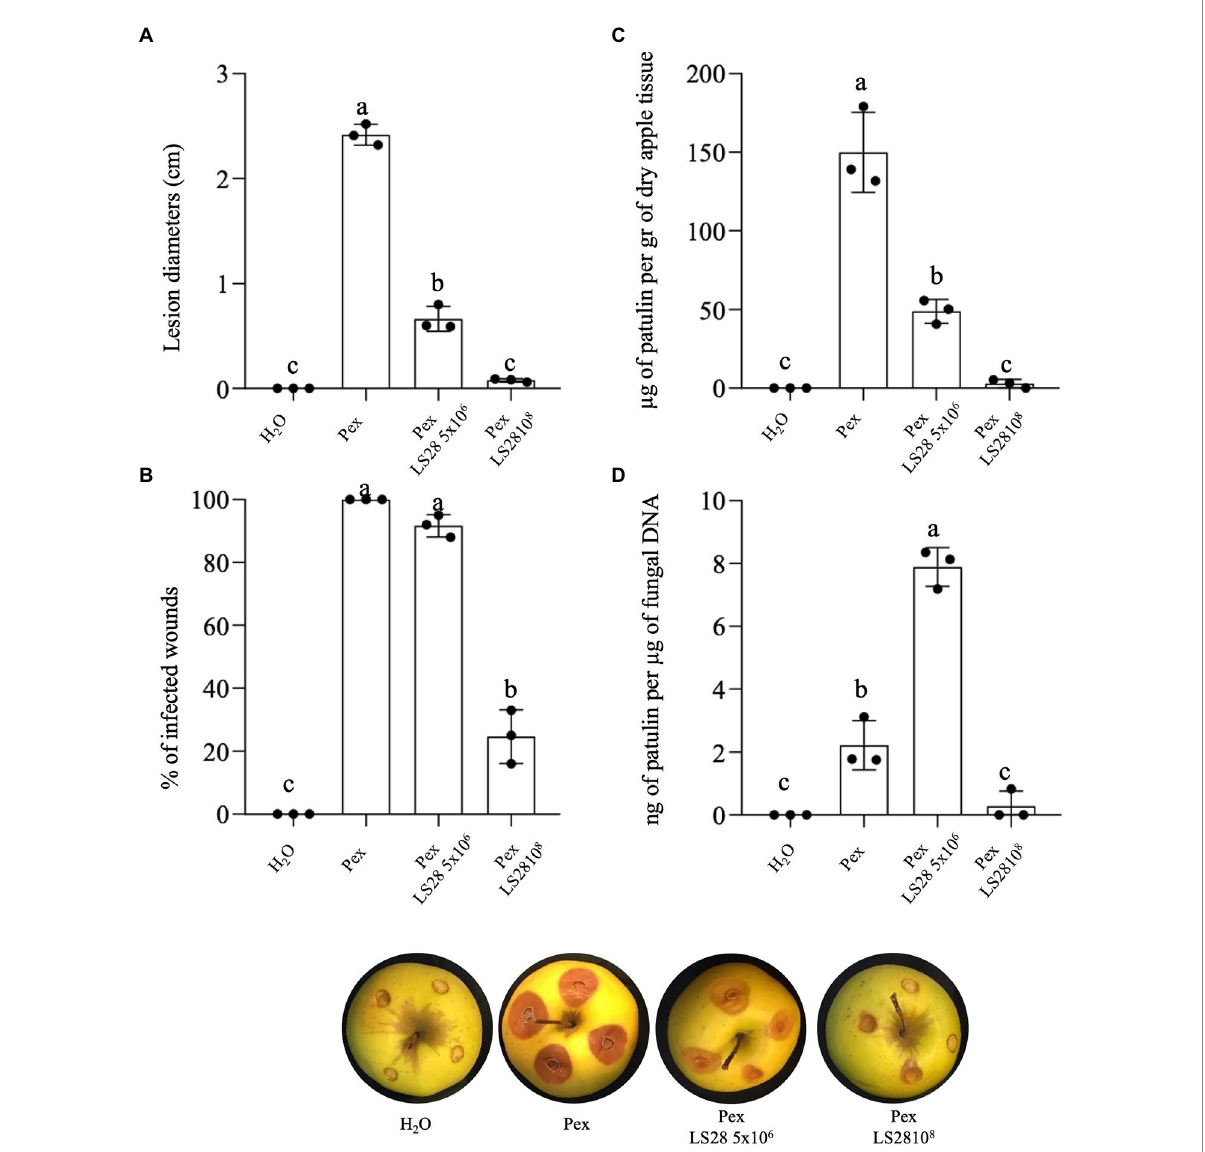
FIGURE 1 Effect of optimal (1 × 10 8 CFU ml − 1 ) and suboptimal (5 × 10 6 CFU ml − 1 ) concentrations of the biocontrol yeast Papiliotrema terrestris LS28 after 7 days of incubation on (A) lesion diameter; (B) percentage of infected wounds; (C) patulin accumulation; (D) specific mycotoxigenic activity, in apples inoculated with P. expansum strain 7015 (Pex). Columns with common letters are not significantly different according to one-way ANOVA followed by Uncorrected Fisher’s LSD comparison test ( p < 0.05). Data shown are the mean values ± SD from three independent experiments (black